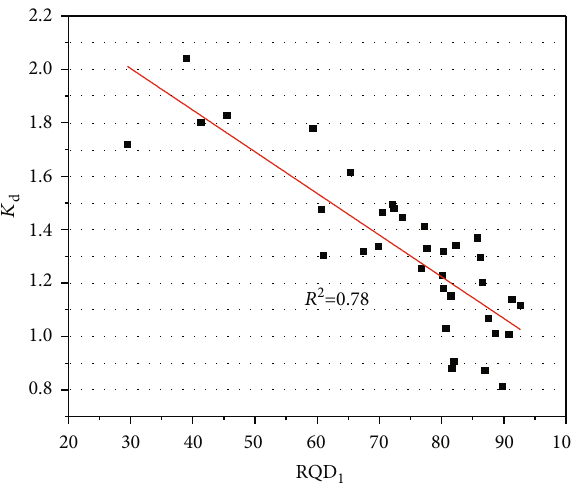
Figure 11: Fracability index variation of the shale gas and K . d I